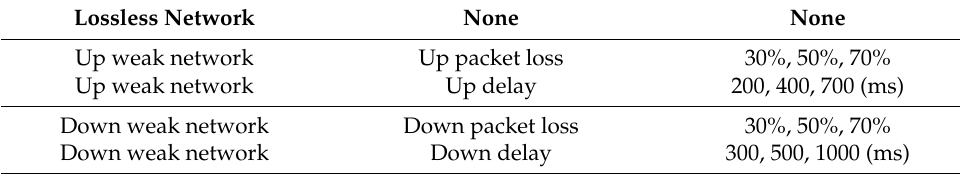
Table 2. Network performance test.